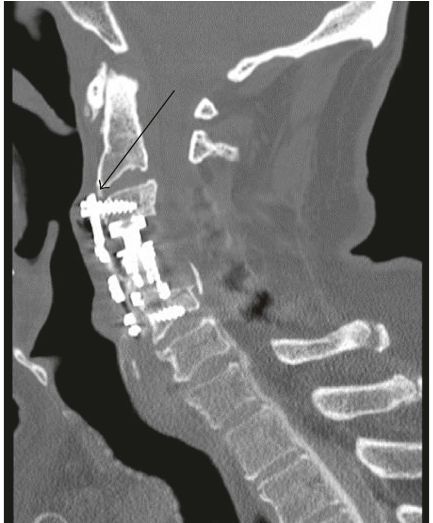
Figure 3: CTneck showing cervical hardware with thinning of the oropharyngeal mucosa. CTmyelogram was negative for leak in this region.